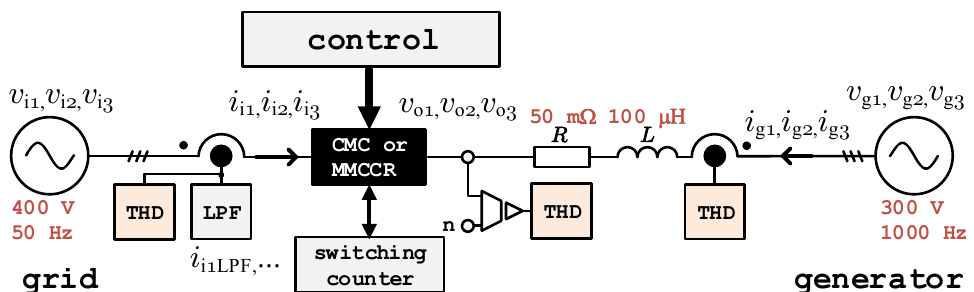
Figure 21. A potential application scheme with a high-speed PMSM generator: CMC—conventional matrix converter, MMCCR—the proposed converter, THD—calculation of the total harmonic distor- tion block, LPF—the low–pass filter, and “n”—the star point for the phase voltage measurement.